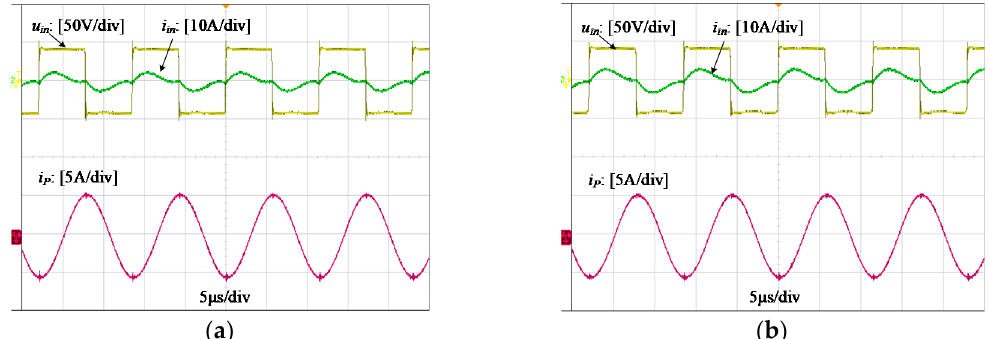
Figure 13. Experimental waveforms of u in , i in , and i P in CC mode when ( a ) R B = 40 Ω and ( b ) R B = 60 Ω .